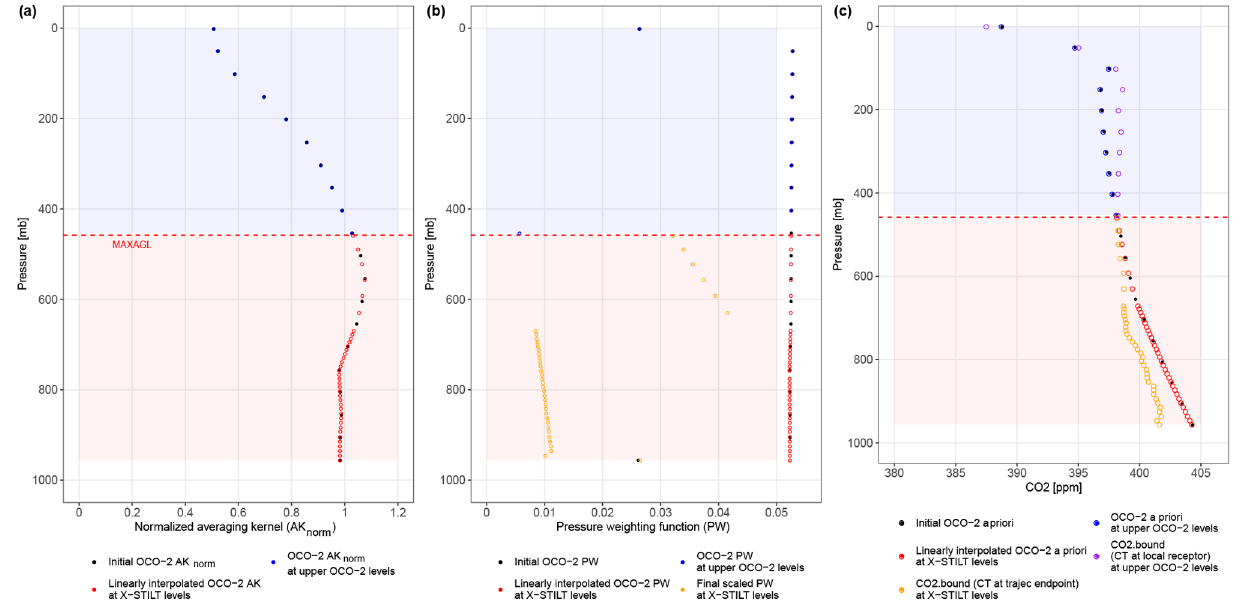
Figure 2. Demonstrations of interpolations on the (a) normalized averaging kernel (AK norm ) profile, (b) pressure weighing (PW) function, and (c) the CO 2 boundary conditions (derived from CarbonTracker – CT-NRT) and OCO-2 a priori profile, given one sounding (with the same lat/long coordinates as column receptors). The red and blue shading denotes the X-STILT release levels from the surface up to MAXAGL and upper OCO-2 levels,